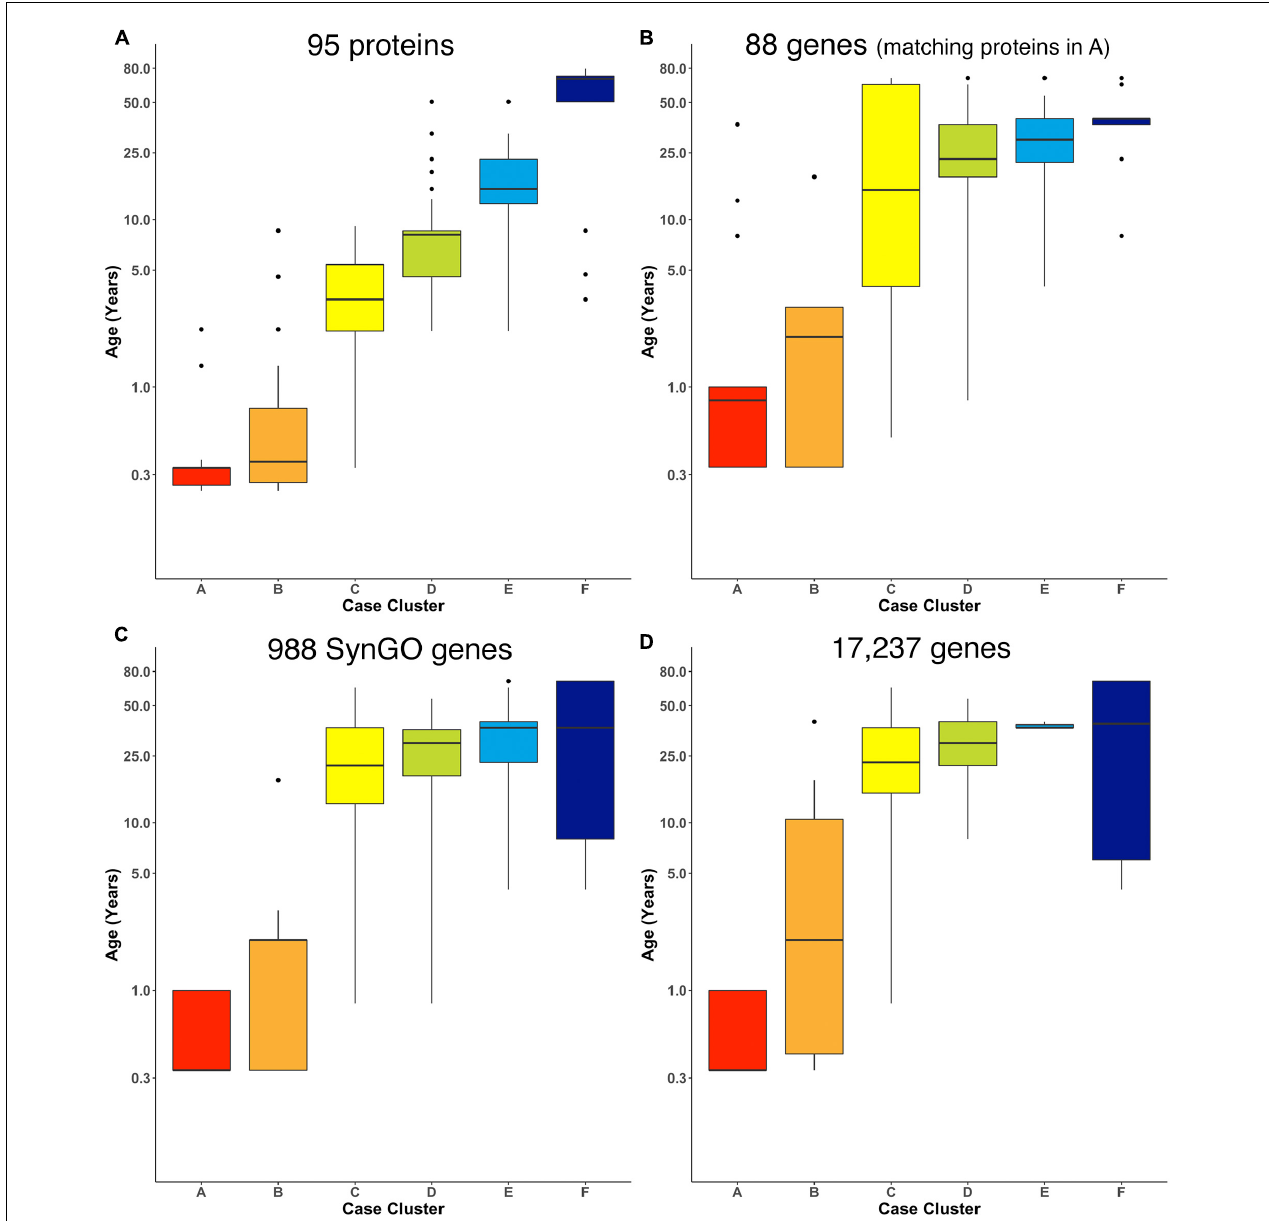
FIGURE 7 | Age-related clusters for large numbers of proteins and genes. Expression data from (A) 95 synaptic and immune-related proteins, (B) 88 genes that correspond with the protein in (A) , (C) 988 synaptic genes that correspond with the SynGO gene list, and (D) 17,237 protein-coding genes was used to identify six age-related clusters. The cluster designation of each sample over 100 iterations of RSKC was used to visualize the distribution of sample ages. Boxplots denote the median and interquartile range of ages in each cluster, and points denote